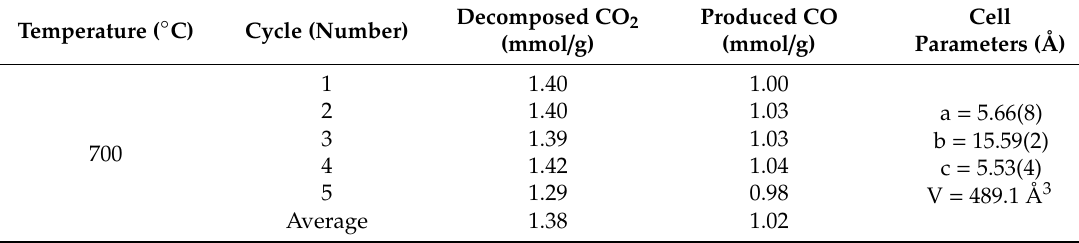
Figure 4. Five cyclic reproducibility tests for CO 2 decomposition using SrFeO 3 − δ at 700 ◦ C: ( a ) Decomposed CO 2 concentration and ( b ) produced CO concentration. Table 2. Results of isothermal cyclic experiments with SrFeO 3 − δ